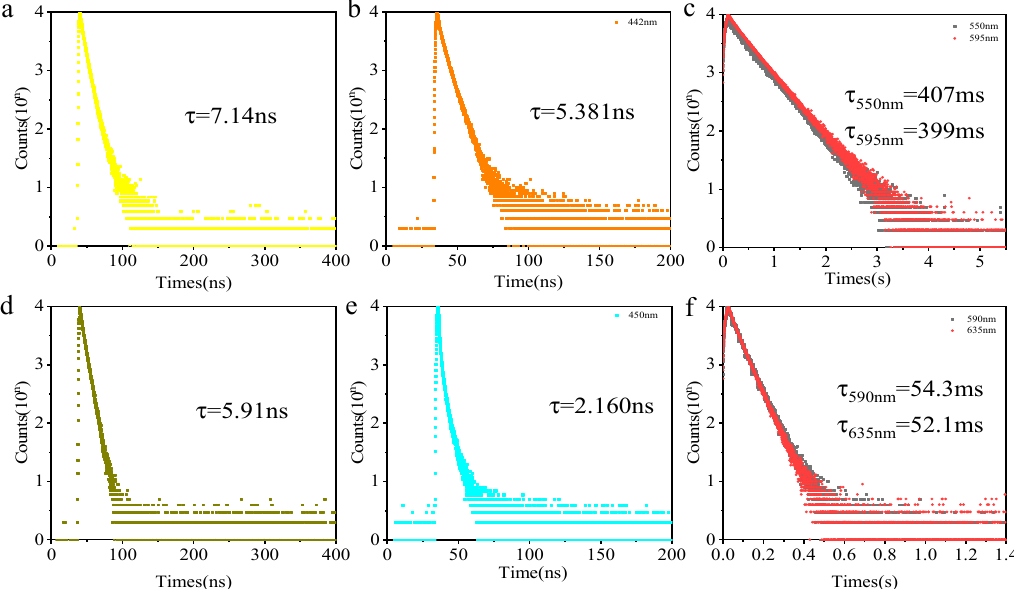
Figure 3. Time-resolved PL decay curves; NI-O-PLA 420 nm ( a , air, 298 k); CZ-NI-O-PLA 442 nm ( b , air, 298 k), 550 and 595 nm ( c , vacuum, 298 k); NI-S-PLA 445nm ( d , air, 298 k); CZ-NI -S-PLA 450 nm ( e , air, 298 k), 590 and 635 nm ( f , vacuum, 298 k); Excitation wavelength: 365 nm.